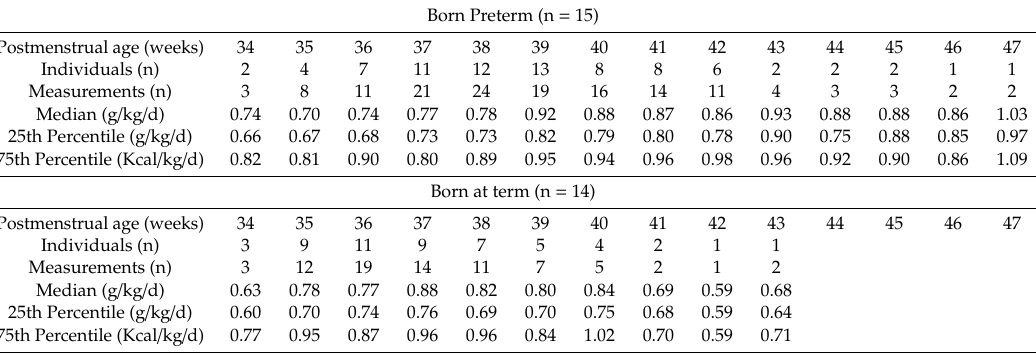
Table 7. Evolution of respiratory quotient in infants born preterm and at